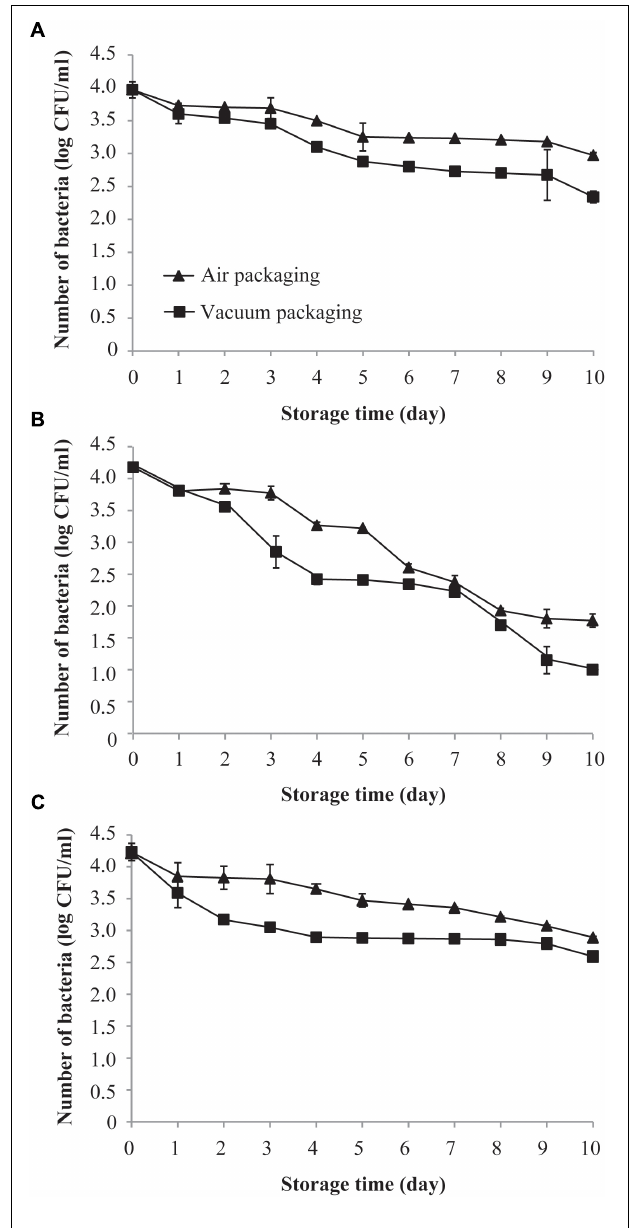
FIGURE 1 | Effects of air packaging and vacuum packaging on the survival of C. sakazakii . (A–C) The survival of C. sakazakii subjected to air packaging or vacuum packaging was assessed at 4 ◦ C (A) , 10 ◦ C (B) , and 25 ◦ C (C) . Values are means ± standard deviation of three replicates.